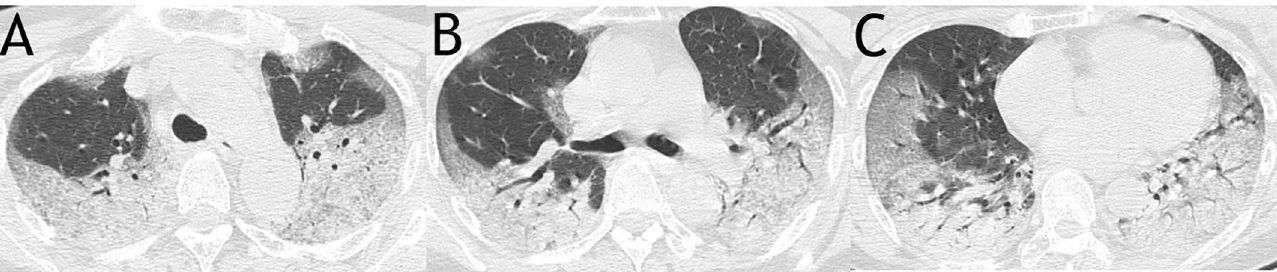
Fig 1. A sample scoring on CT images of a 63-year-old woman from mortality group demonstrated a total score of 63. It was calculated as: for upper zone (A), 3 (consolidation) × 3 (50–75% distribution) × 2 (both right and left lungs) + 2 (ground glass opacity) × 1 ( < 25% distribution) × 2 (both right and left lungs); for middle zone (B), 3 (consolidation) × 2 (25–50% distribution) × 2 (both right and left lungs) + 2 (ground glass opacity) × 2 (25–50% distribution) × 2 (both right and left lungs); for lower zone (C), 3 (consolidation) × (2 (25–50% distribution of the right lung) + 3 (50–75% distribution of the left lung)) + 2 (ground glass opacity) × (2 (25–50% distribution of the right lung) + 1 ( < 25% distribution of the left lung)).